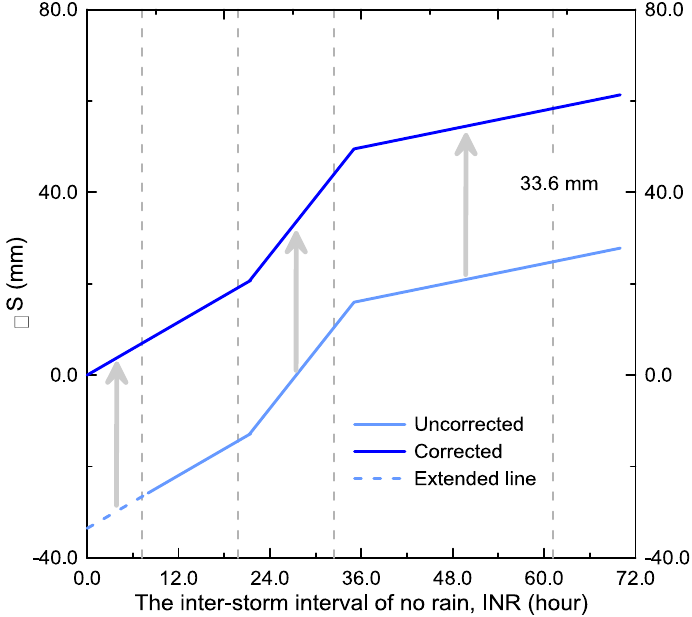
Figure 10. Diagram of the R-curve adjustment process: In this figure, the arrows represent the adjustment process of the uncorrected R-curve.